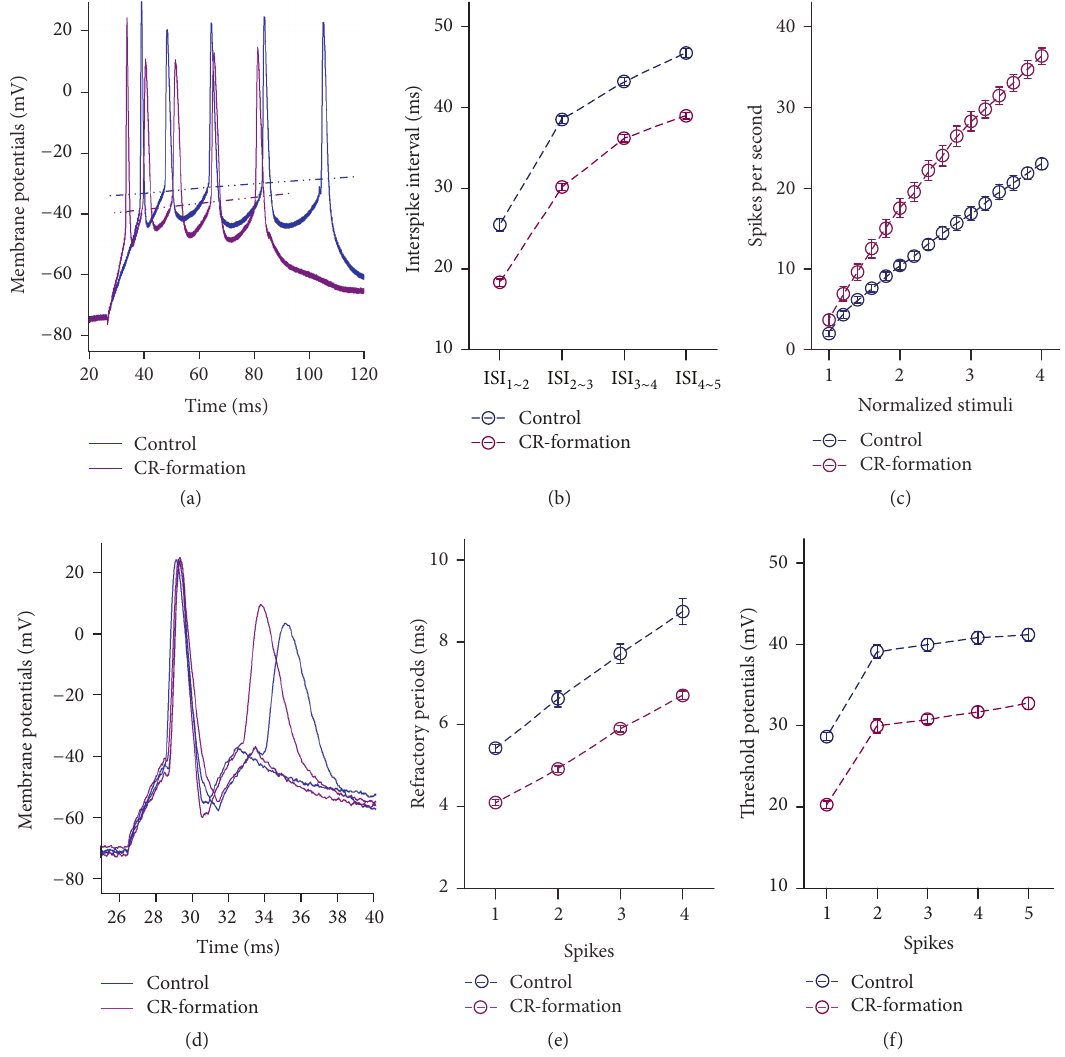
Figure 4: The capability to encode spikes on barrel cortical pyramidal neurons increases after pairing WS and OS. The spikes were induced by depolarization pulse under voltage-clamp recording on glutamatergic neurons in cortical slices. (a) Traces illustrate depolarization-induced spikes on the neurons from control (blue trace) and CR-formation (dark-red). (b) shows interspike intervals for spikes 1 ∼ 2 to spikes 4 ∼ 5 from controls (dark-blue symbols, 𝑛 = 21 ) and CR-formations (dark-red symbols, 𝑛 = 20 ). (c) shows spikes per second versus normalized stimuli from control (dark-blue symbols, 𝑛 = 21 ) and CR-formation (dark-red symbols, 𝑛 = 20 ). (d) Traces show the measurements of spike refractory periods on the neurons from controls (dark-blue trace) and CR-formations (dark-red). (e) shows refractory periods versus spikes 1 to 4 from controls (dark-blue symbols, 𝑛 = 21 ) and CR-formations (dark-red symbols, 𝑛 = 20 ). (f) shows the threshold potential versus spikes 1 to 5 from controls (dark-blue symbols, 𝑛 = 21 ) and CR-formations (dark-red symbols, 𝑛 = 20 ).